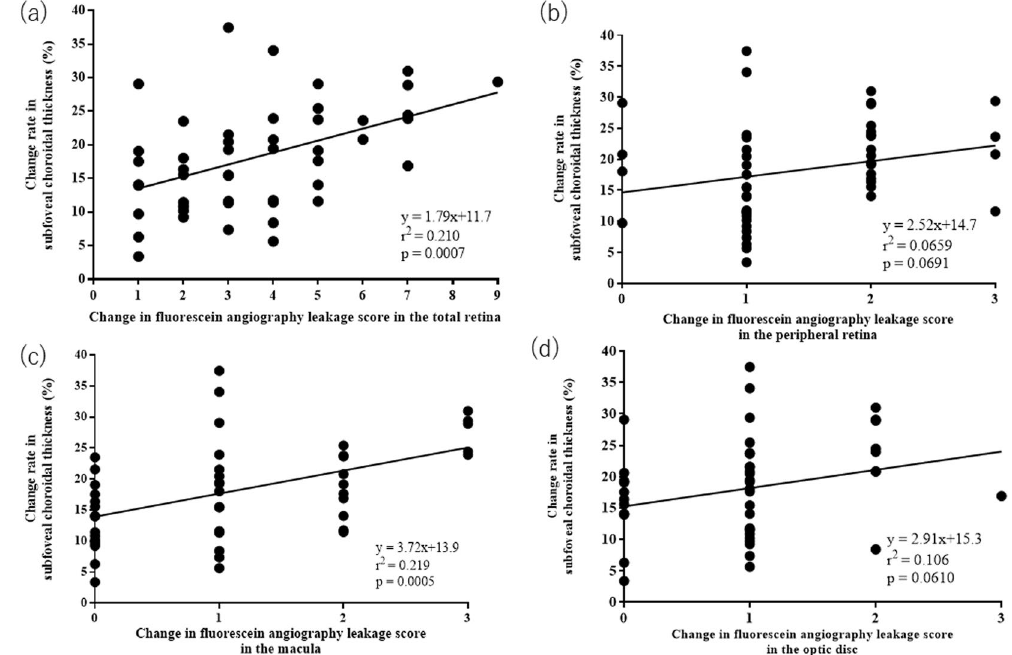
Figure 4. Association between the changes in subfoveal choroidal thickness (SCT) and those in the fluorescein angiography (FA) leakage score of the total retina ( a ), peripheral retina ( b ), macula ( c ), and optic disc ( d ). The associations between these parameters were evaluated using linear regression analysis for the total retina ( a ), peripheral retina ( b ), macula ( c ), and optic disc ( d ). The changes in SCT are significantly correlated with those in the FA leakage score of the total retina (r 2 = 0.210, p < 0.05, linear regression analysis) and macula (r 2 = 0.219, p <